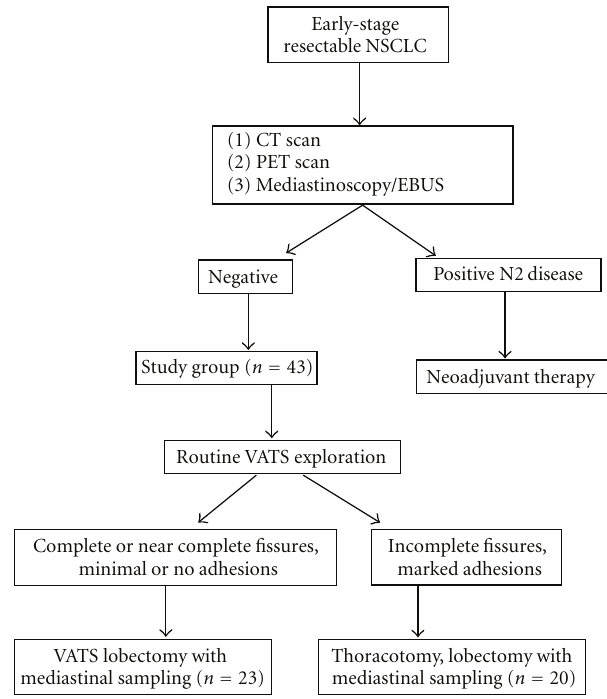
Figure 1: Flow diagram of the 43 patients recruited for the